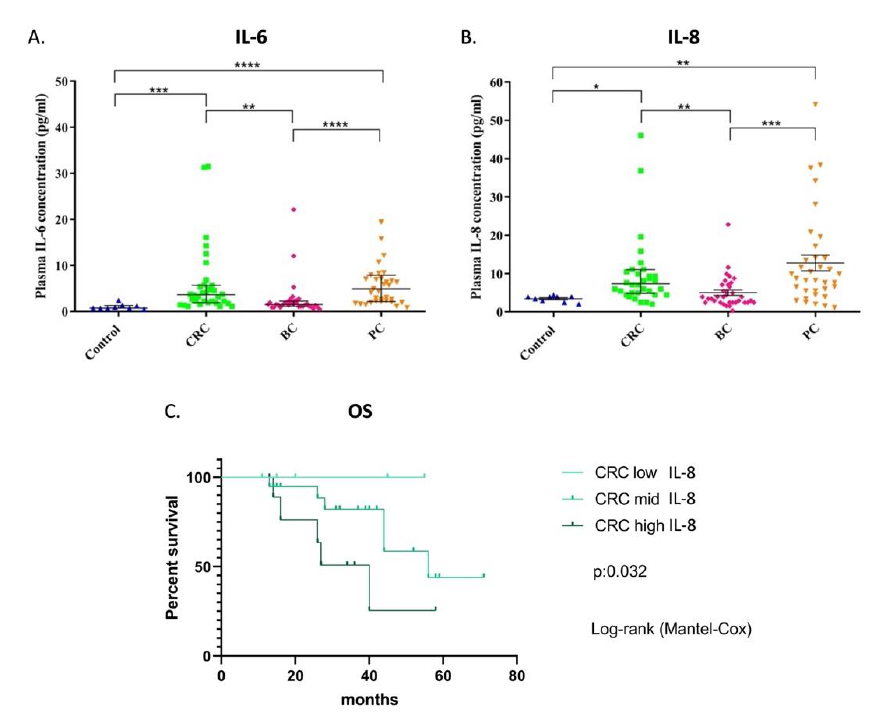
Figure 3. IL-6 ( A ) and IL-8 ( B ) cytokine levels in colorectal, breast and pancreatic cancer patients. Overall survival in colorectal cancer patients based on the plasma level of IL-8 cytokine ( C ) . *: 0.01 < p < 0.05, **: 0.001 < p < 0.01, *** 0.0001 < p < 0.001 and ****: p < 0.0001.